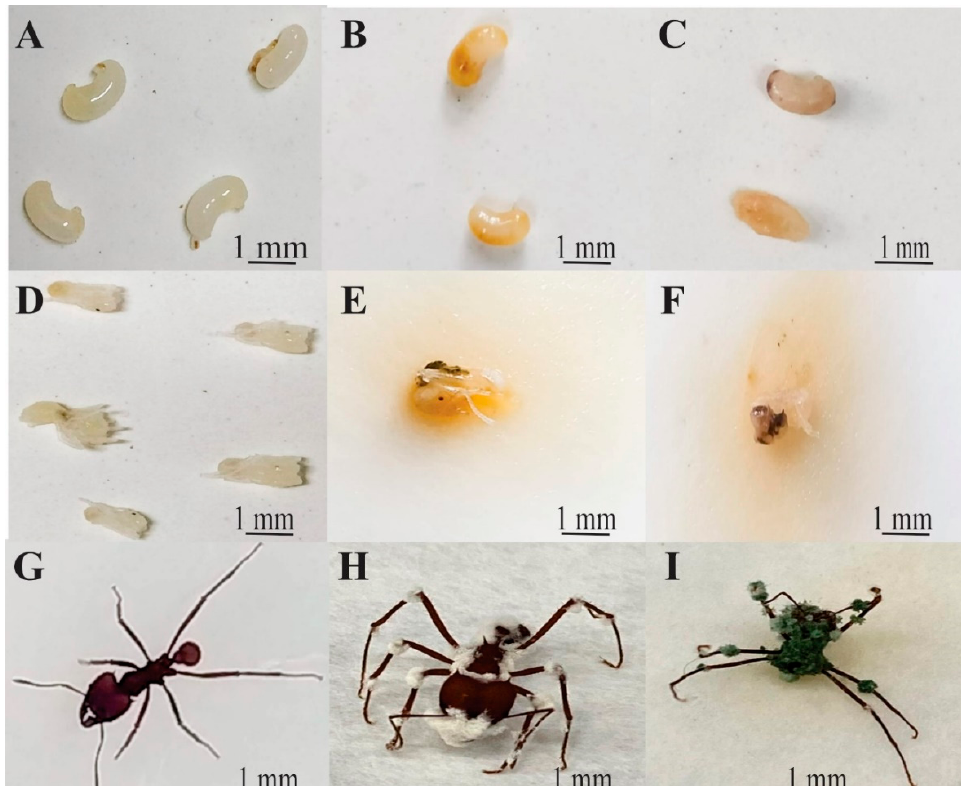
Figure 1. Stages of Atta sexdens rubropilosa Forel 1908 (Hymenoptera: Formicidae) exposed with the different entomopathogens under laboratory conditions: ( A ) healthy pupae; ( B ) pupae exposed with Beauveria bassiana ; ( C ) pupae exposed with Trichoderma harzianum ; ( D ) healthy larvae; ( E ) larvae exposed with Beauveria bassiana ; ( F ) larvae exposed with Trichoderma harzianum ; ( G ) healthy worker; ( H ) worker exposed with Beauveria bassiana ; ( I ) worker exposed Trichoderma harzianum .